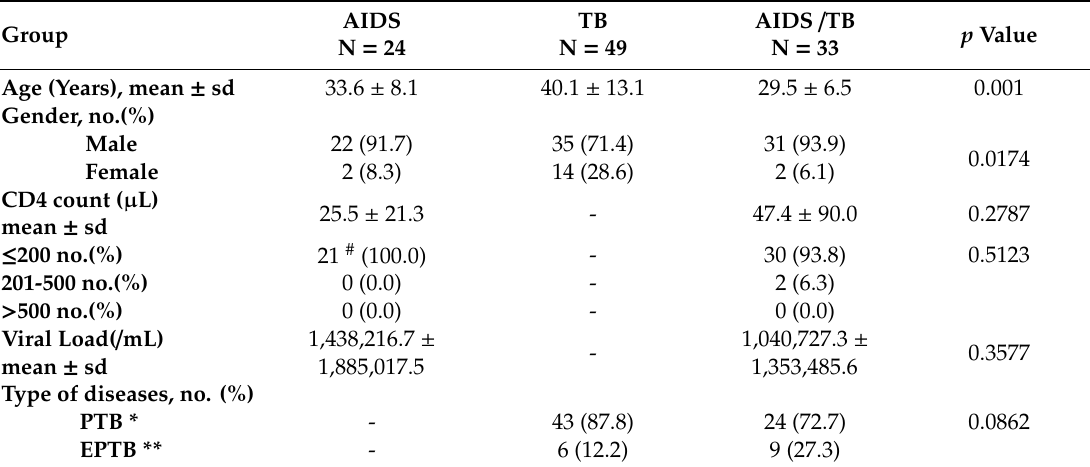
Table 1. Characteristics of AIDS, TB, and AIDS / TB